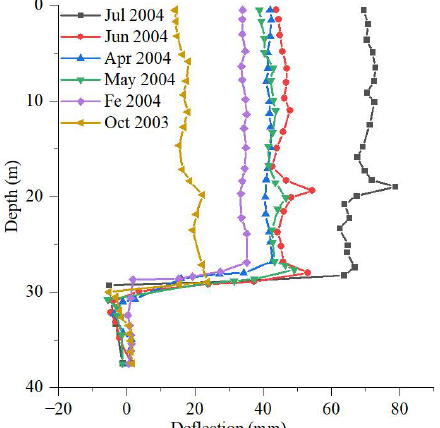
Figure 5. Movement of inclinometer ZK-1 at the upper part of the Baijiabao landslide.